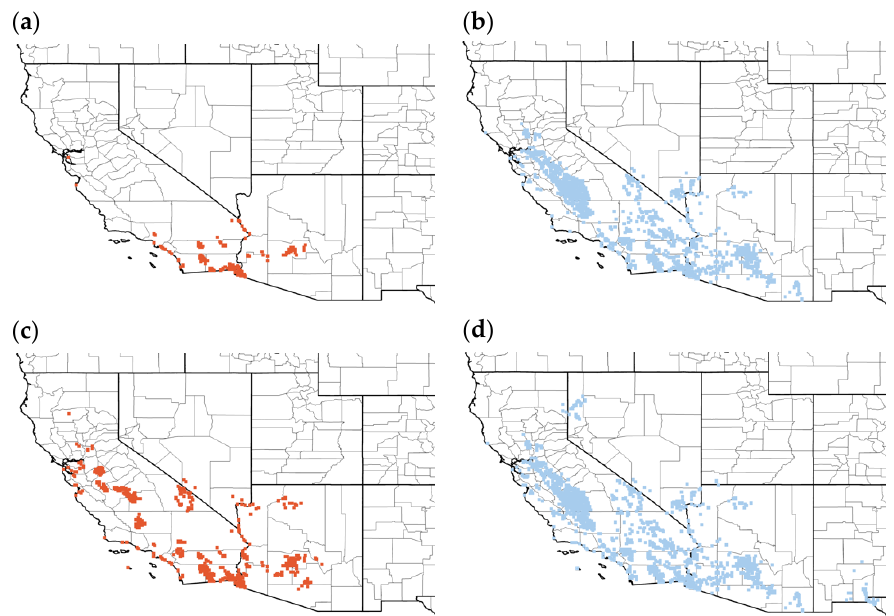
Figure 10. Areas in southwest United States (by counties) where Chia could be potentially grown based on land use, precipitation, and temperature criteria (note: 32 °F = 0 °C, 28 °F = −2 .2 °C). ( a ) 25 mm rainfall and 32 °F in December ( b ) 25 mm rainfall 32 °F in November ( c ) 25 mm rainfall and 28 °F in December ( d ) 25 mm rainfall and 28 °F in November.